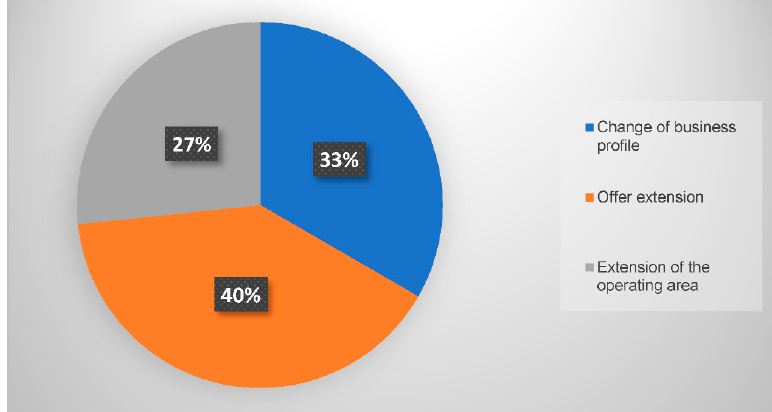
Figure 10. Percentage share of examined decisions.